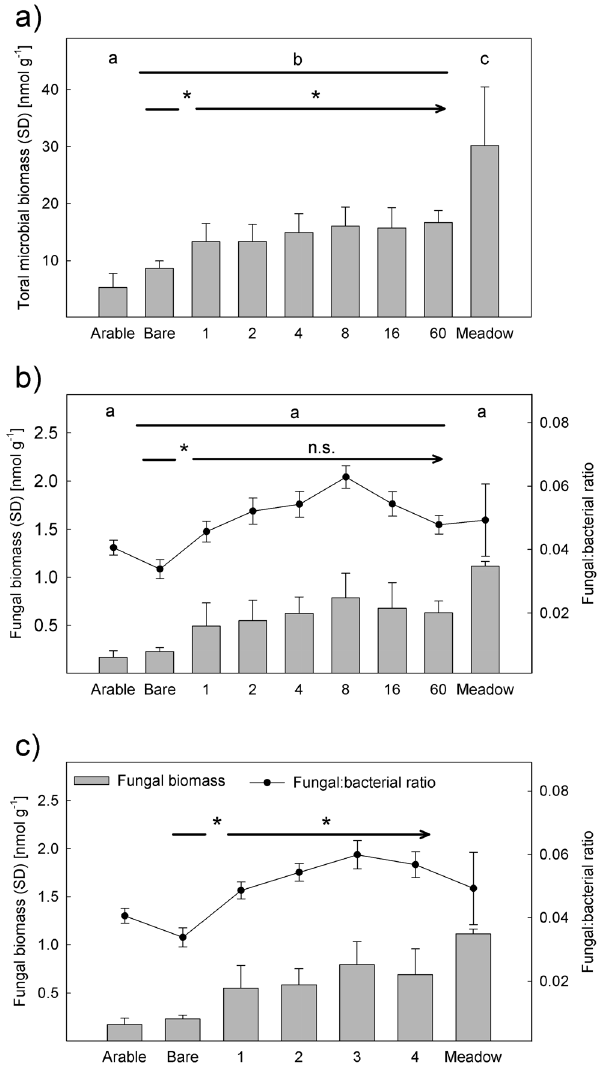
Figure 1. Impact of land use and plant diversity soil microbial community. Differences ( P , 0.05) between experimental plots and control sites (arable land and semi-natural meadows) were analyzed with Tukey’s HSD test and indicated by letters. Differences between bare ground vs. vegetated plots and significant effects of plant diversity were tested with ANOVA (Table 1) and indicated by asterisks ( P , 0.05). Figures show effect of plant species richness on (a) total microbial biomass (b) fungal biomass and the fungal-to-bacterial biomass ratio and (c) number plant functional groups effect on fungal biomass and the fungal-to-bacterial biomass ratio.